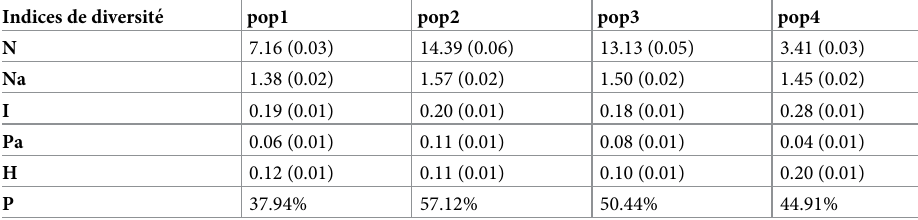
Table 2. Variation of different genetic parameters among the four identified subpopulations.